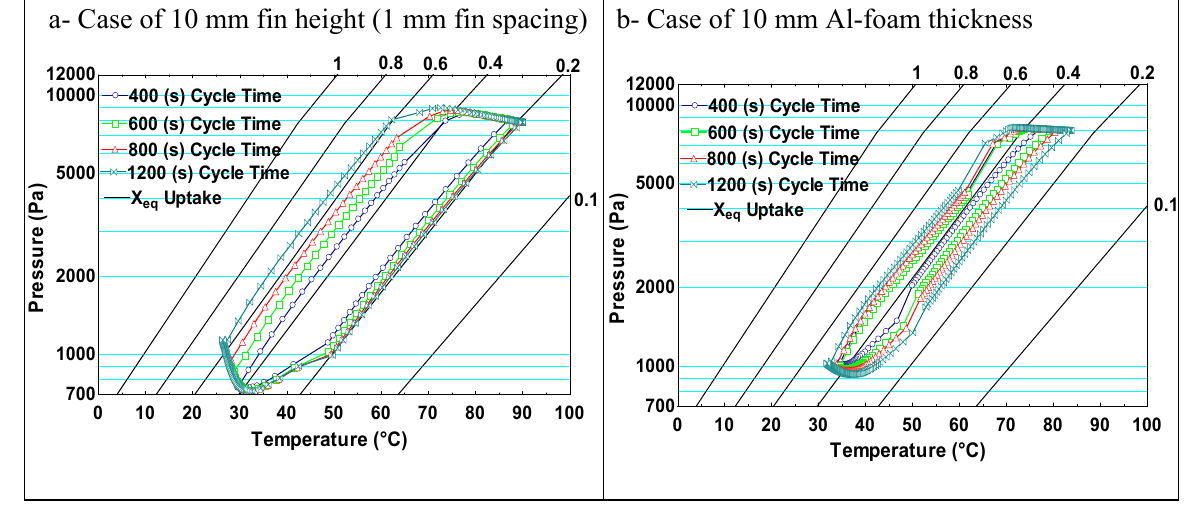
Figure 9. The T-P-X diagram for the bed of both systems during the cyclic steady state at different cycle times and 10 mm fin height/foam thickness. ( a ) Finned-tube based bed, ( b ) Al-foam based bed. Figure 10 demonstrates the net effect of changing the cycle time using 10 mm foam thickness compared with the finned tube bed of 10 fin height on the COP and DIP of the two-bed adsorption ice maker. The COP and DIP of the Al-foam based system were reduced dramatically when a higher foam thickness of 10 mm was employed. The system COP and DIP were reduced by 63.8% and 75.8% at a cycle time of 400 s, while they were reduced by 1% and 35.8% at a cycle time of 1200 s, respectively, compared with the base model of 1 mm fin spacing.